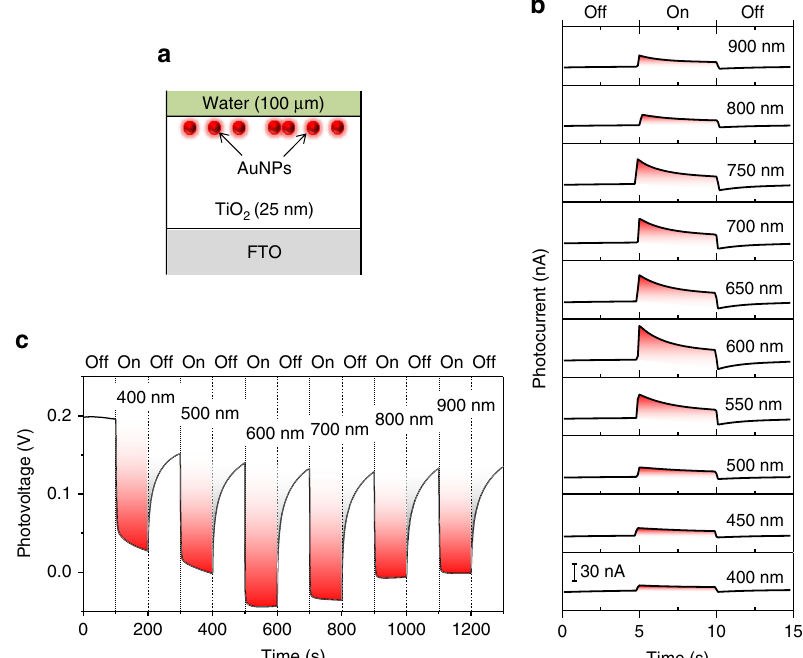
Fig. 5 Absence of the hot-electron interplay effect without the Au fi lm. a Schematic of the device in which the 200 nm thick Au fi lm is absent. A 500 nm thick fl uorine-doped tin oxide (FTO) layer on glass is used as the substrate for the fabrication of the TiO 2 layer. b Results of the photocurrent measurements. c Results of the photovoltage